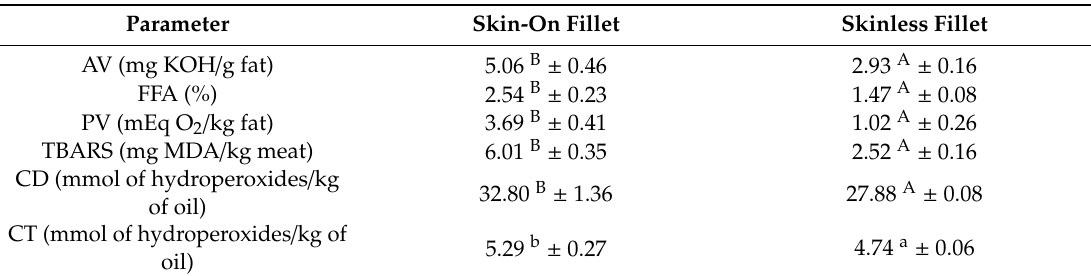
Table 3. Acid value (AV), free fatty acids (FFA), peroxide value (PV), thiobarbituric acid reactive substances (TBARS), and content of conjugated dienes (CD) and trienes (CT) of Prussian Carp ( Carassius gibelio ) fillets (mean ± SD).